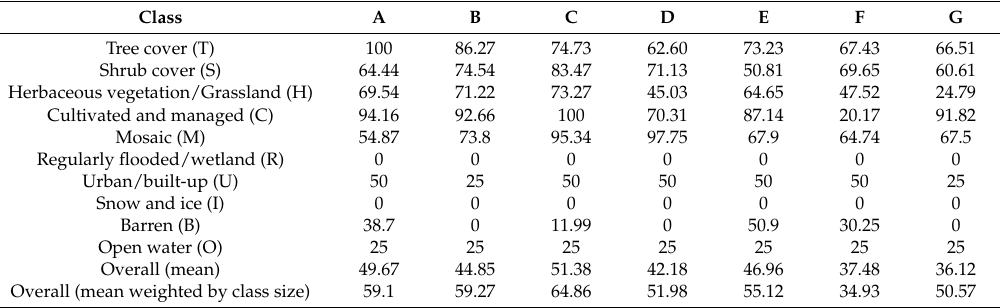
Table 1. Per-class and overall classification accuracies (%) for the seven volunteers obtained from the latent class